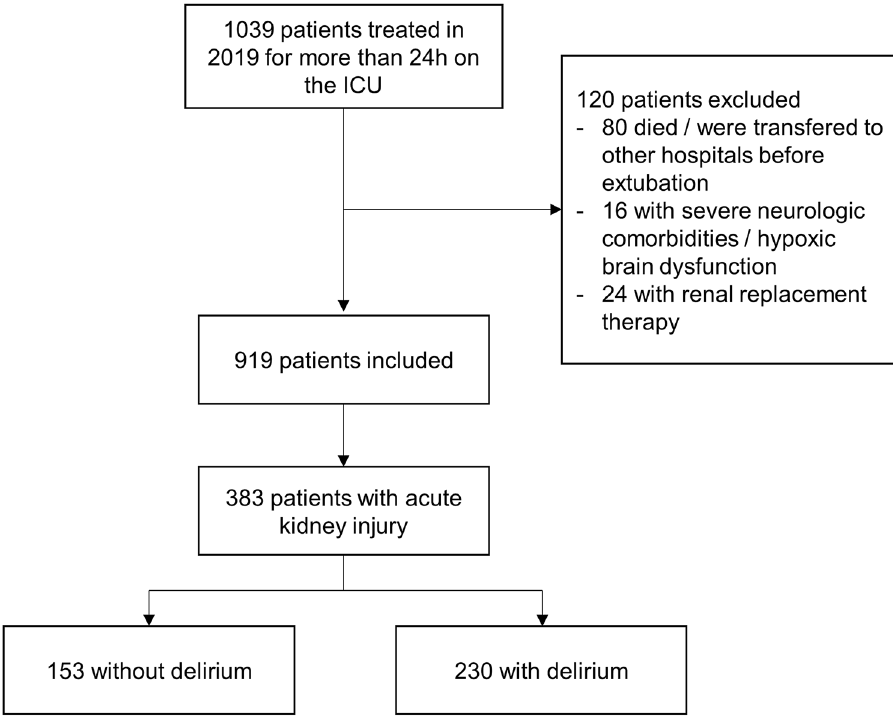
Figure 1. Flowchart indicating number of included and excluded patients. Data are given as number of patients.